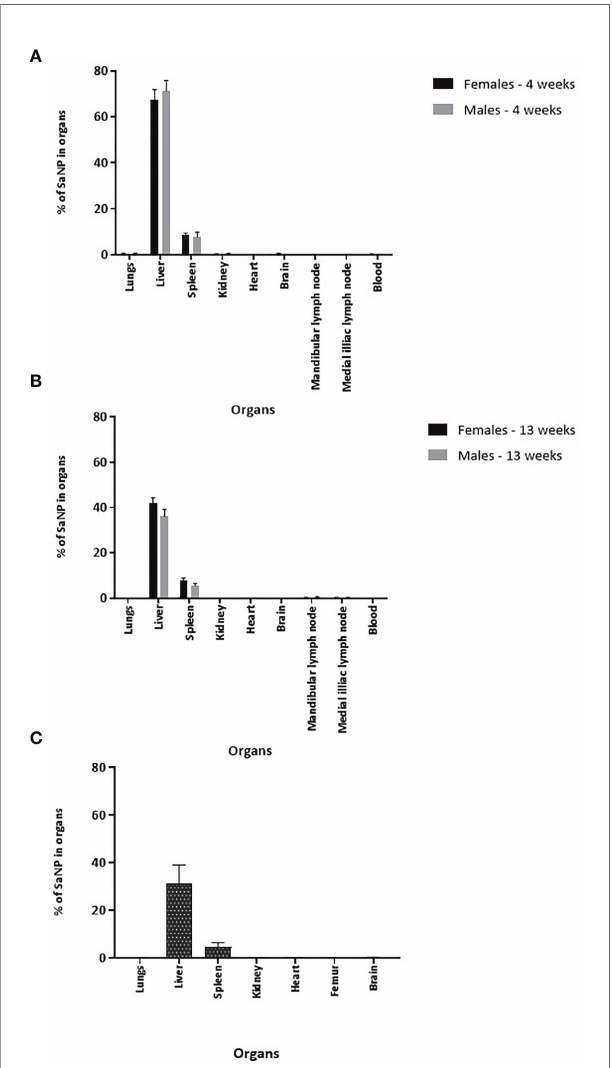
FIGURE 3 | Long-term tissue biodistribution of SaNPs. (A) Residual SaNP in the organs and blood of BALB/c mice at 4 weeks after a single treatment. (B) Residual SaNP at 13 weeks after a single treatment. (C) Residual SaNP at 25 weeks after 3 repeated treatments. Samples were analyzed by pEPR for the quantitation of IO content. Results are expressed as the percentage of SaNP in the various organs and blood normalized per